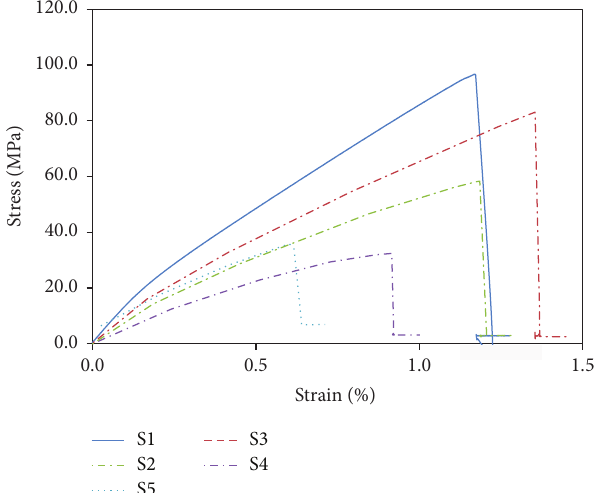
Figure 12: Tensile-stress-strain curves for kenaf composites.